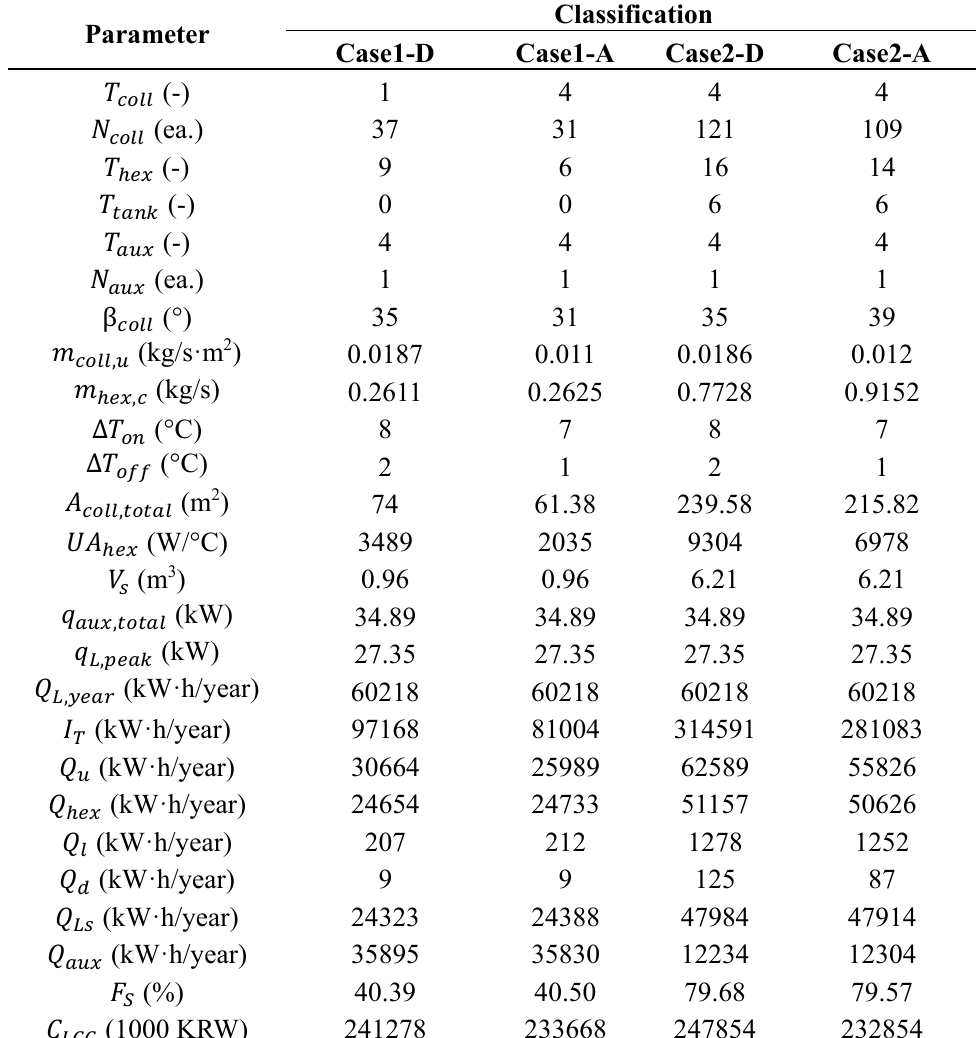
Table 3. Characteristics of the optimal SWH systems for each